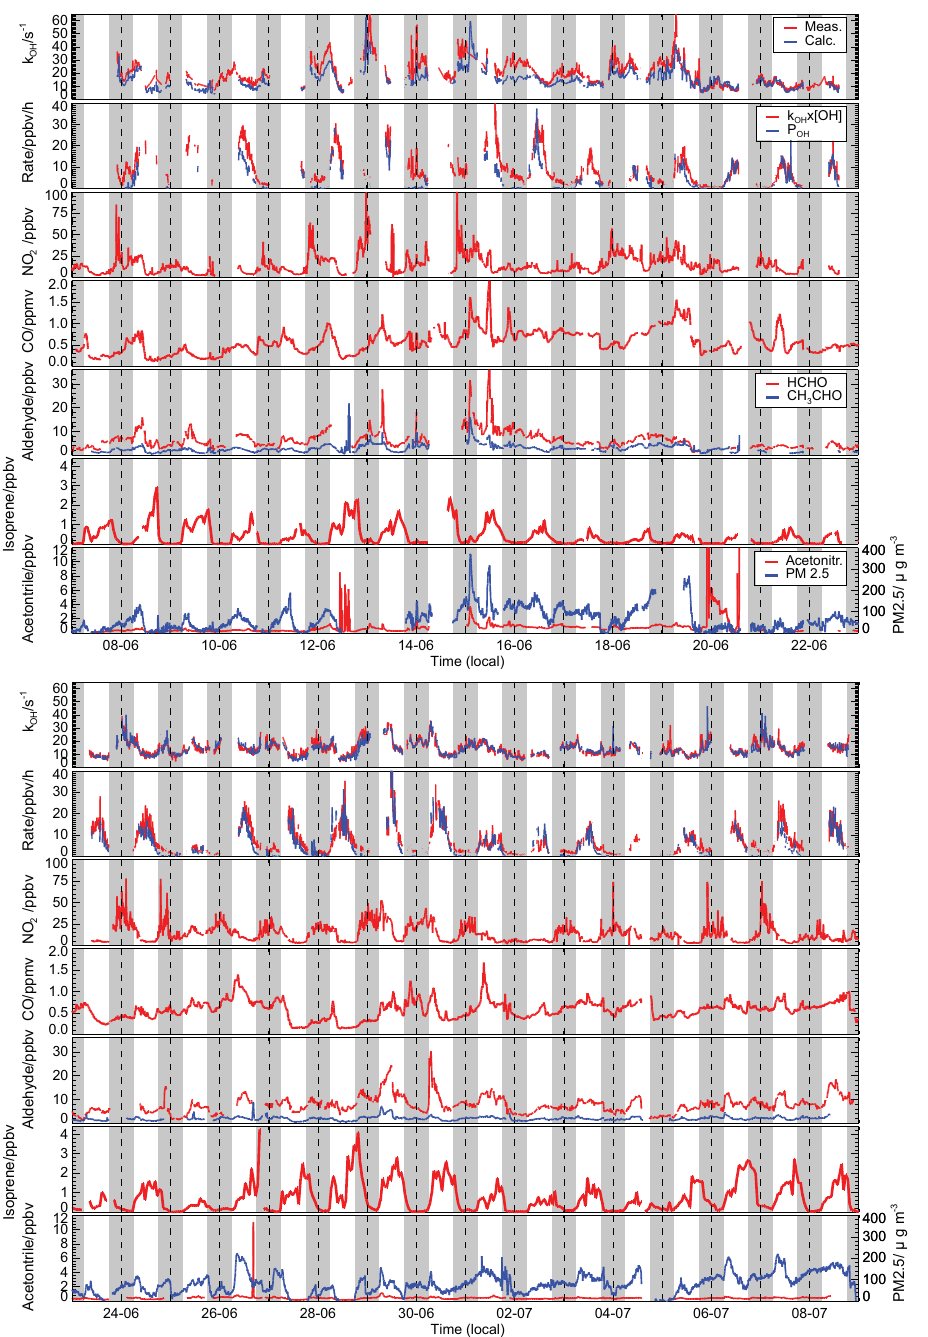
Figure 2. Time series of measured and calculated OH reactivity. In addition, time series of the OH destruction rate ( D OH ) calculated from measured OH concentrations and OH reactivity is shown together with the sum of measured OH production rates ( P OH ) from O 3 and HONO photolysis and reactions of HO 2 with NO and O 3 . Lower panels give time series of important trace gas measurements contributing to the OH reactivity. Gray areas indicate nighttime.